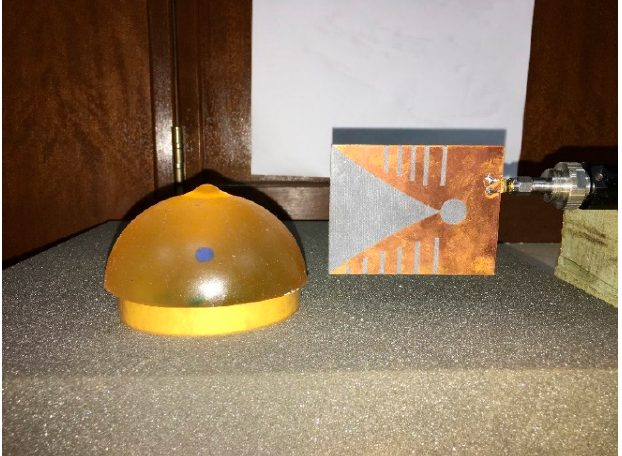
Figure 3. Reflection coefficient measurement with a phantom load.